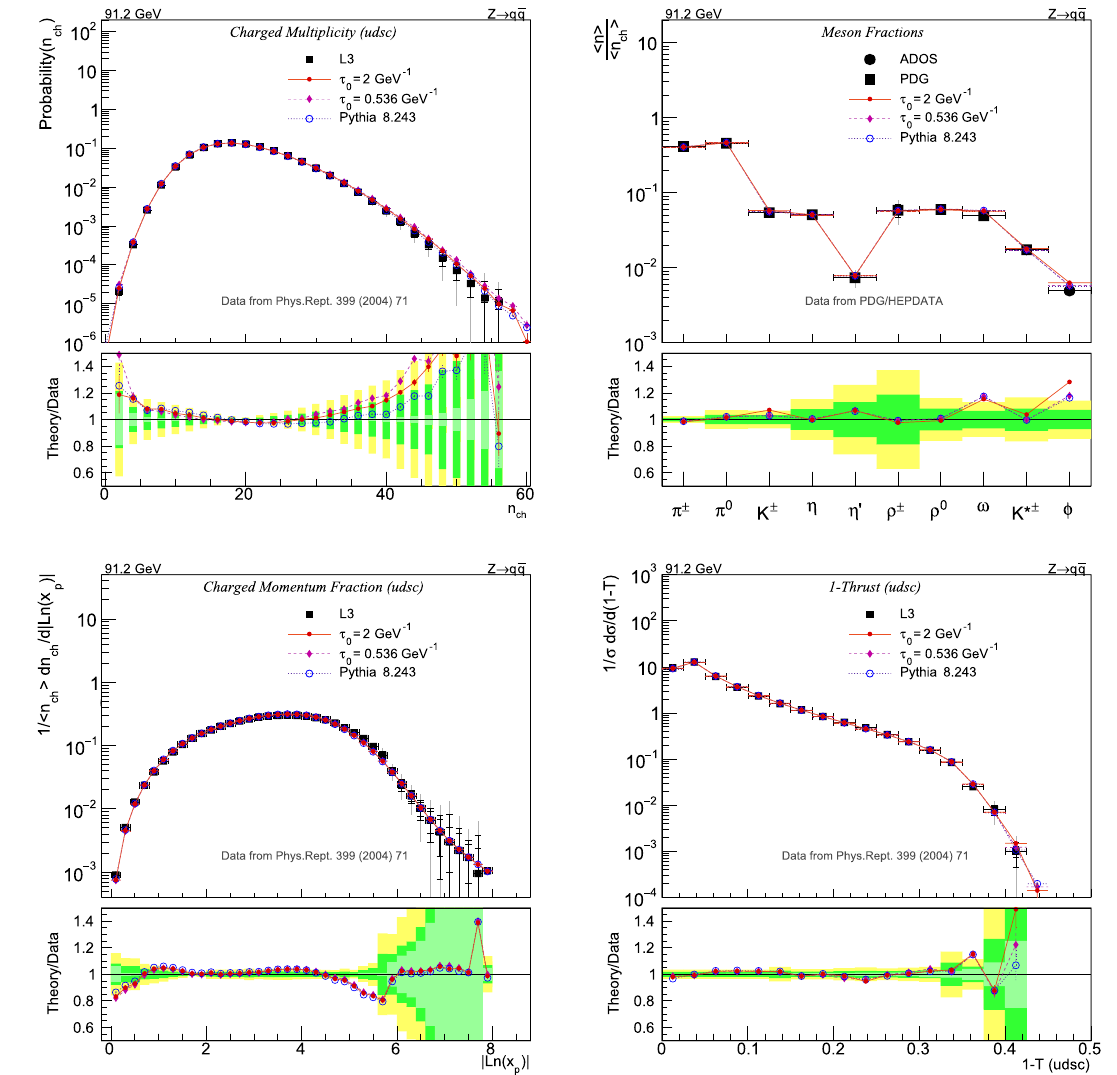
Fig. 3 Overalleventpropertiesinhadronic Z decays,specificallythechargedmultiplicity(topleft),mesonfractions(topright),chargedmomentum spectrum (bottom left), and Thrust distribution (bottom right). Data from